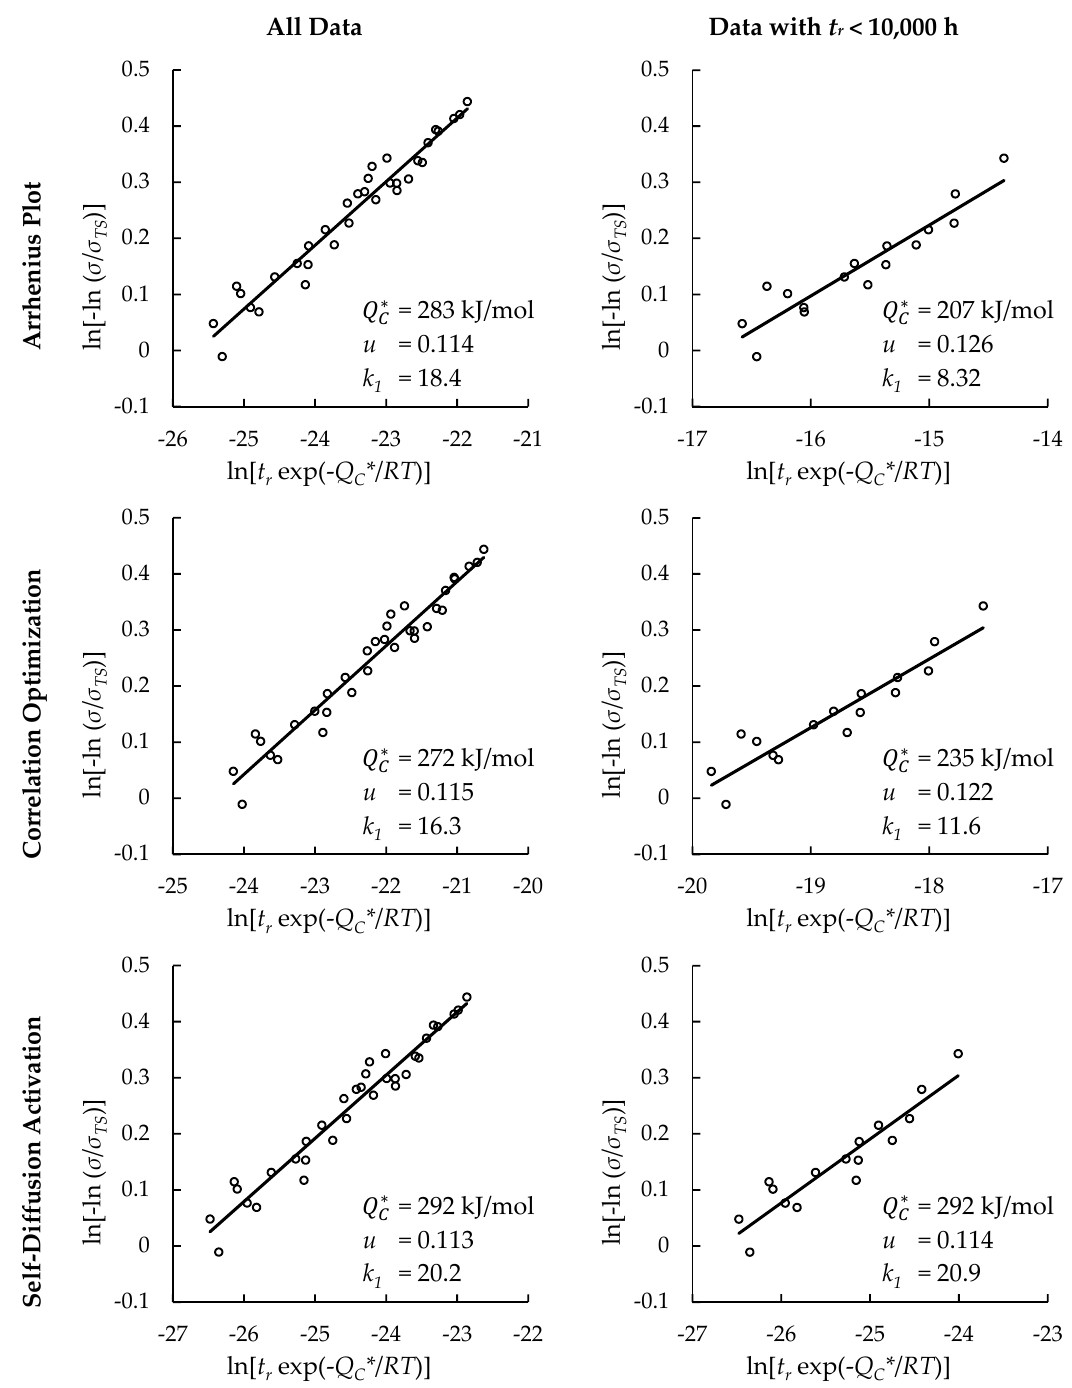
Figure A5. Wilshire plots of Nimonic 105 creep rupture data using heat- and processing-specific tensile strength values.